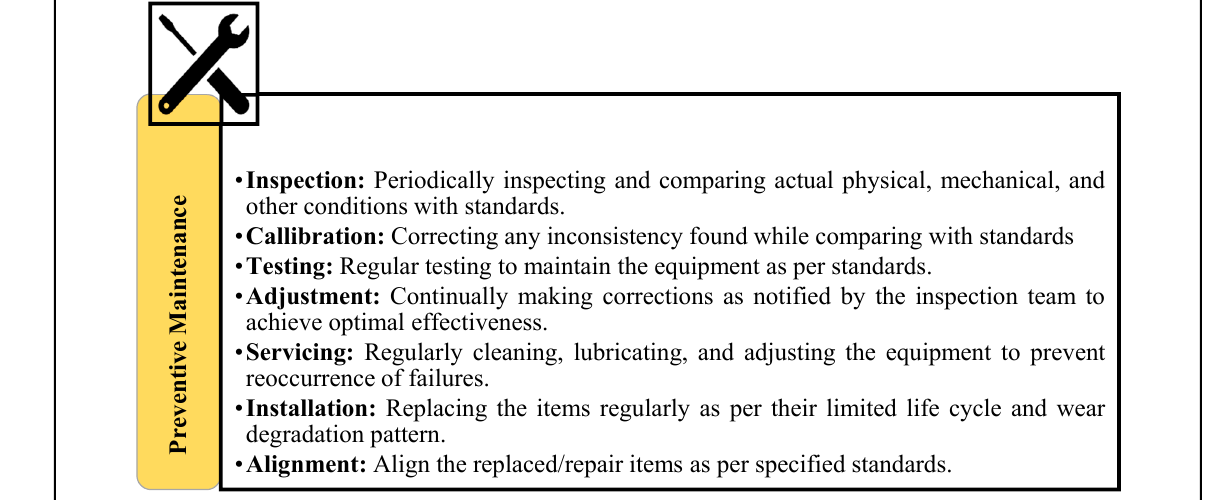
Figure 10. Elements of preventive maintenance.